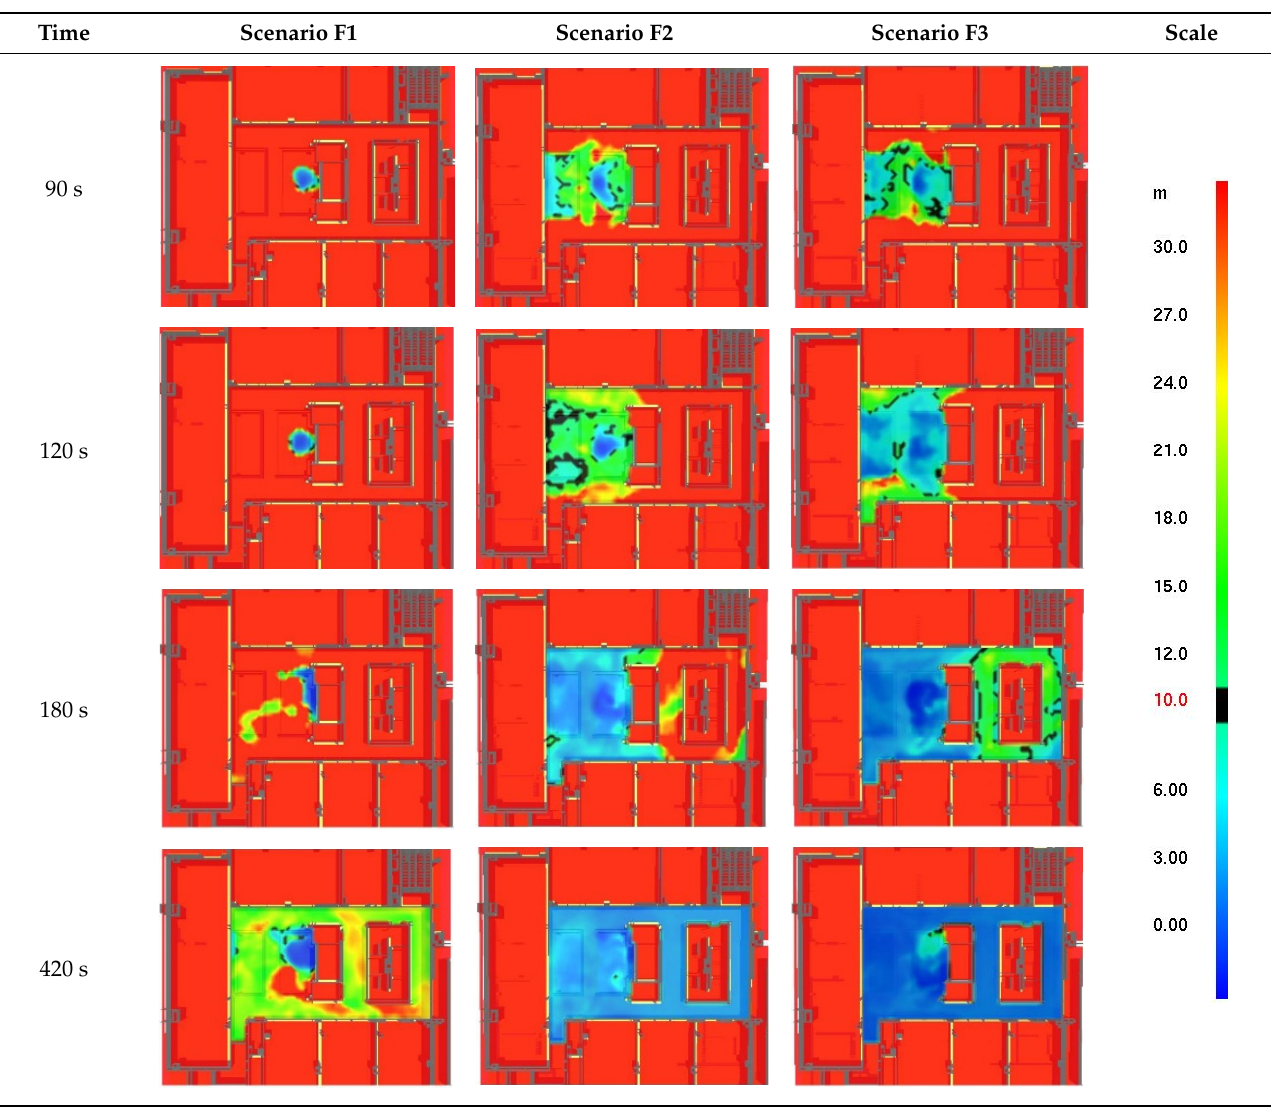
Table 3. Visibility at the level of 1.8 m from the first floor.